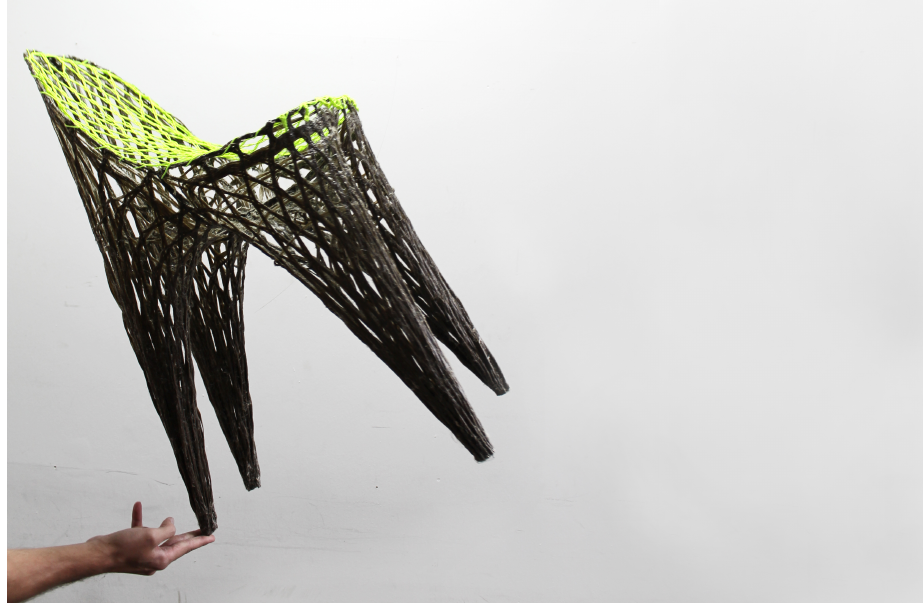
Figure 27. Tailored Lace chair prototype. Lightweight